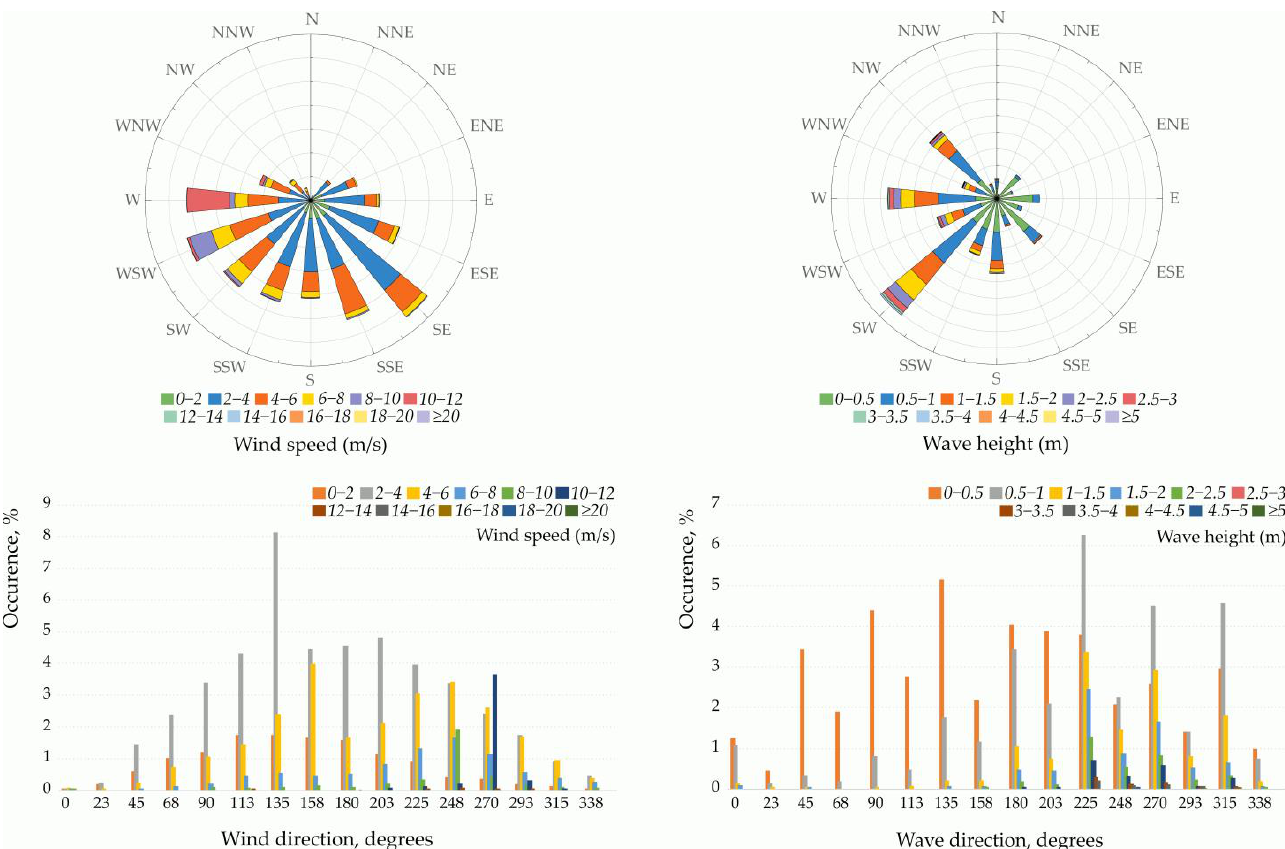
Figure 7. The wind rose diagram for wind direction and speed (m/s) from 2003 to 2021, a wave rose diagram for wave direction and mean wave height (m) from 2003 to 2019, the frequency distribution of wind speed (m/s) from 2003 to 2021, and frequency distribution of wave height (m) from 2003 to 2019.